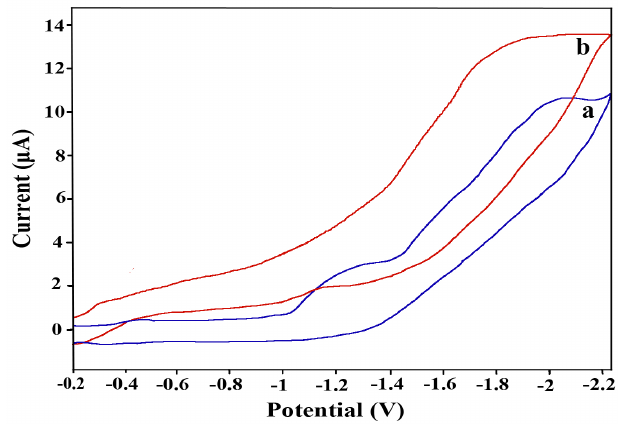
Fig. 9. Cyclic voltammograms of Gd 3) (a) in the absence and (b) presence of CO mV/s; in dry acetonitrile; 0.1 M